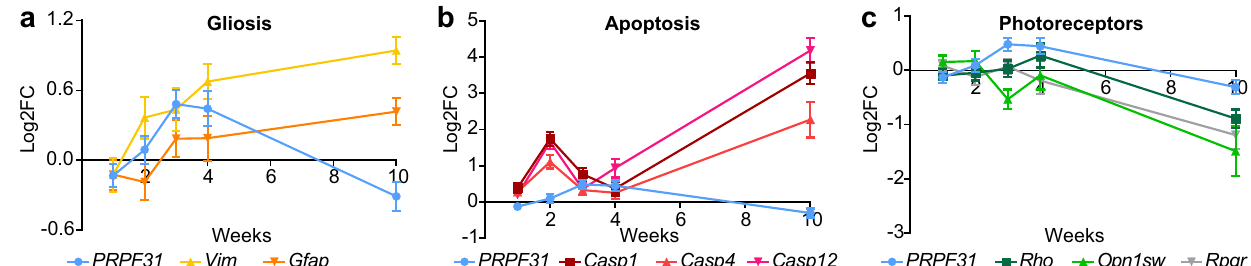
Fig.3|TimecourseofdifferentialgeneexpressioninKOretinarelativetoPBS injected retina (n=3). Expression of Prpf31 is shown in all panels. a Marker genes for Müllercell gliosis ( Vim and Gfap ). b Markersof apoptosis ( Casp1, Casp4 , and Casp12 ). c photoreceptor markers ( Rho,Opn1sw and Rpgr ).Data are shown as